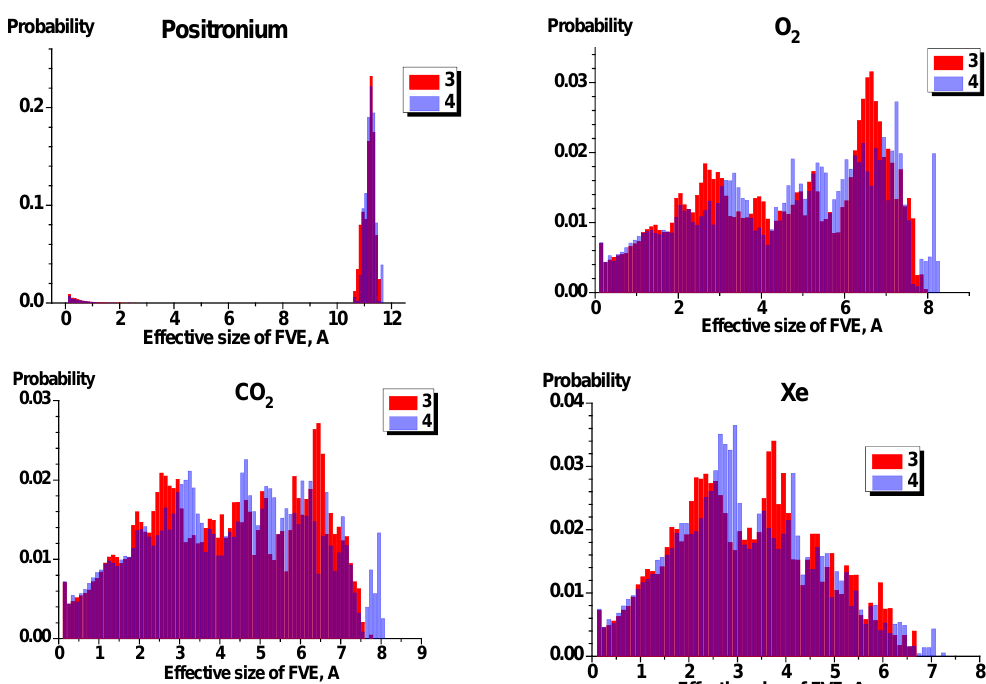
Figure 9. Bar graph distribution of FVE accessible from PTCNSi 2 v (1) and PTCNSi 2 g (2) models [15]. Bar graph bin is equal to 0.1 Bar graph bin is equal to 0.1 Å.